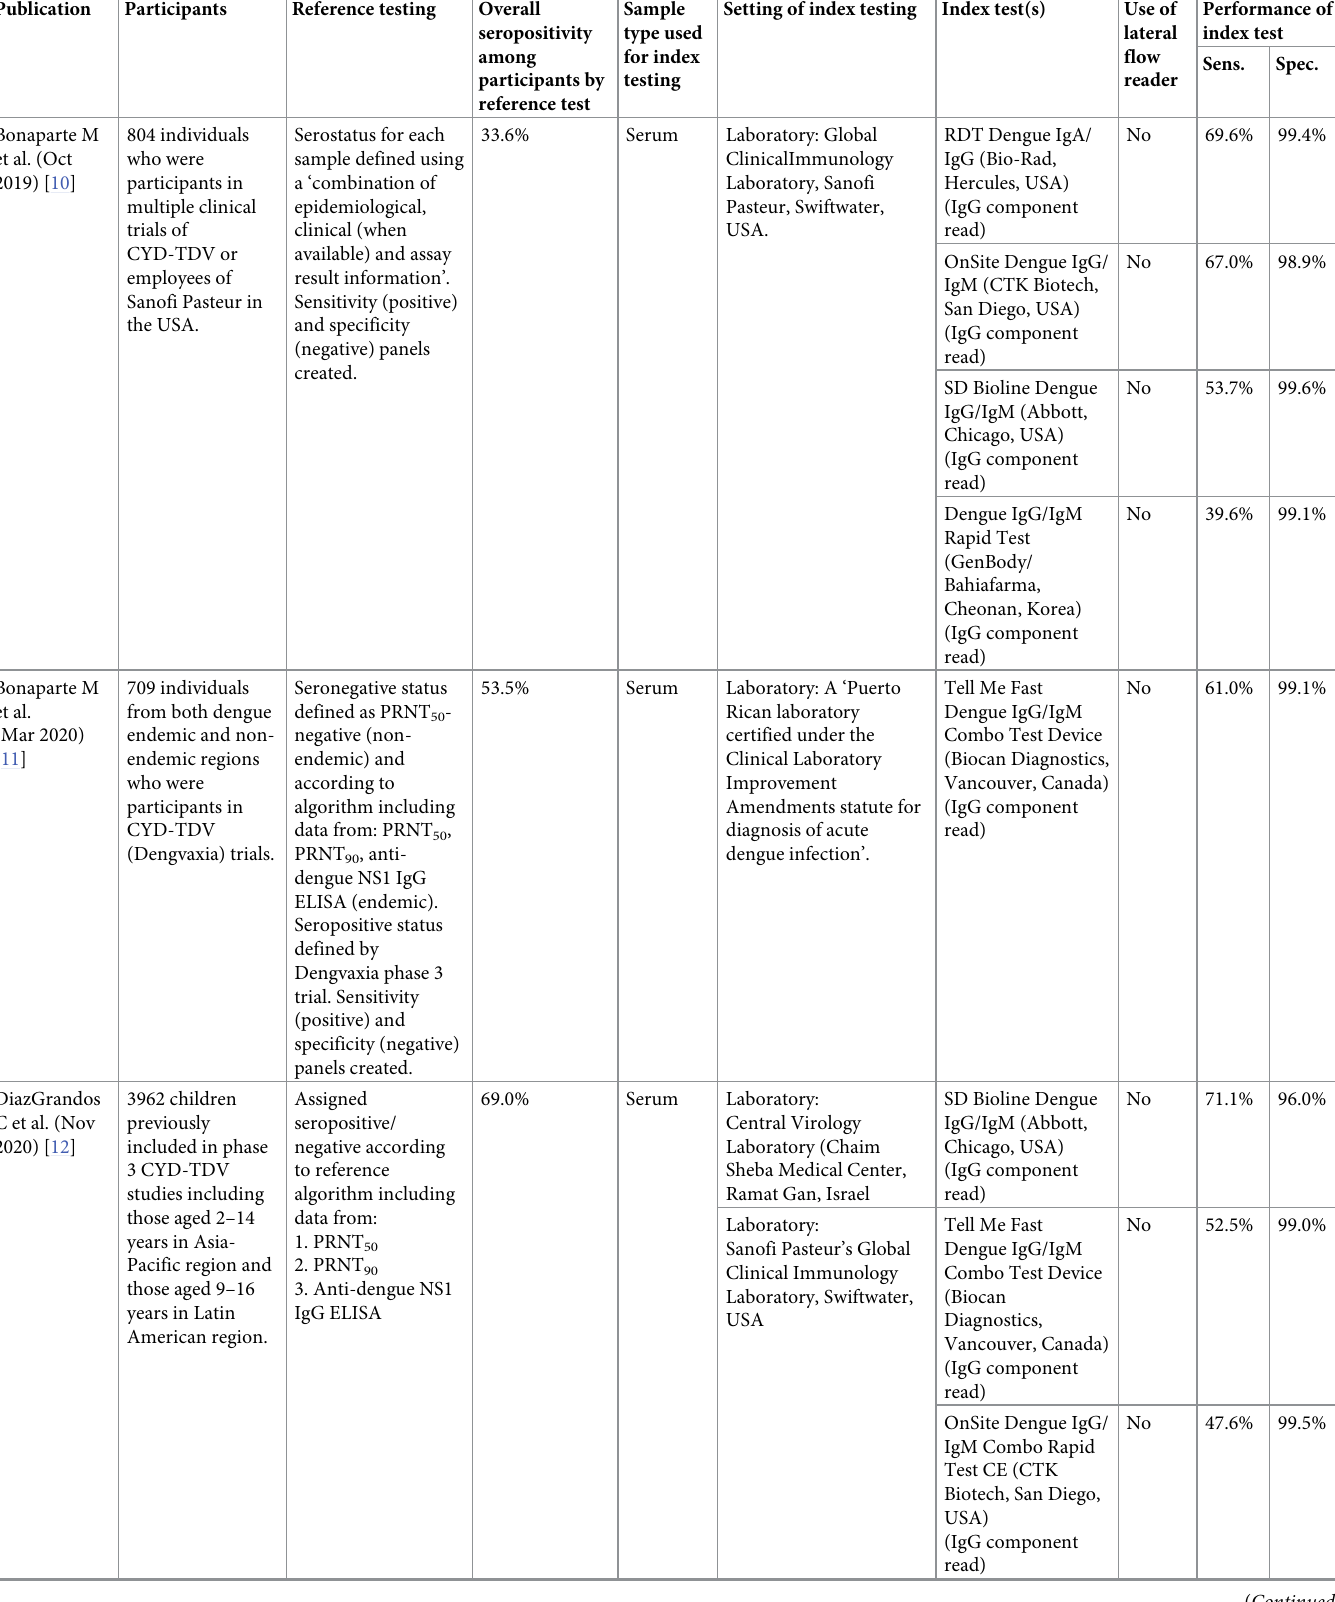
Table 1. Summary of previous studies assessing performance of rapid diagnostic tests in determining dengue